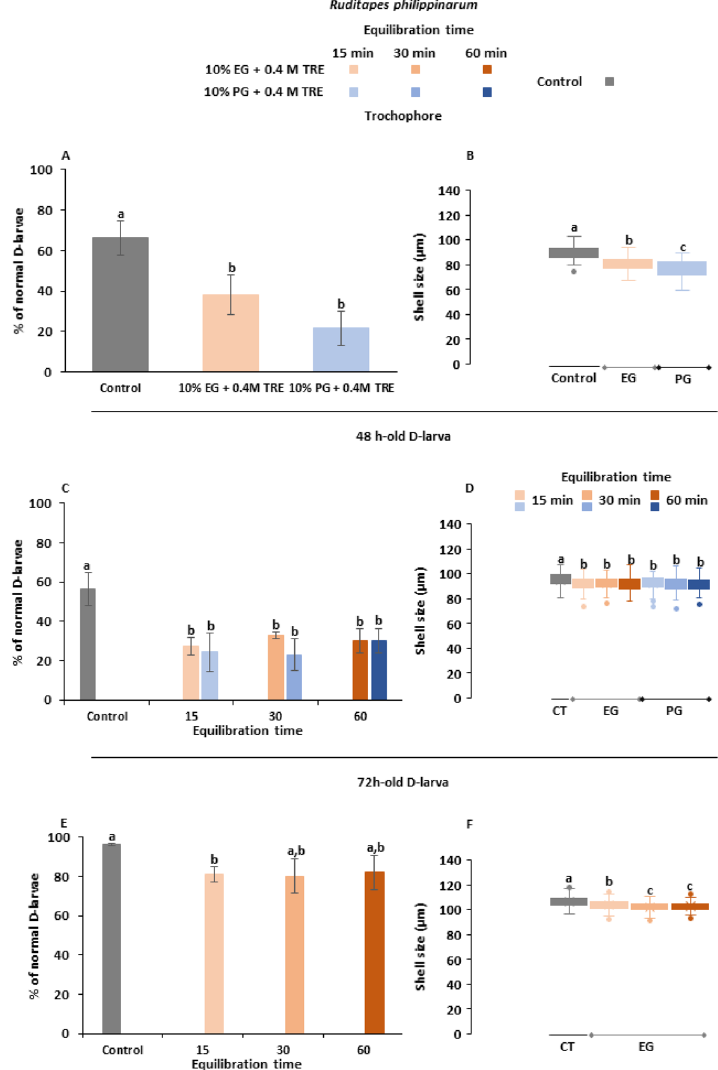
Figure 6. Post-thaw fitness parameters on larvae of Ruditapes philippinarum cryopreserved at trochophore, 48 and 72 h-old D-larval stages: (A) survival of cryopreserved trochophores; (B) shell size of developed D-larvae from cryopreserved trochophores; (C) survival of cryopreserved 48 h-old D-larvae; (D) shell size of developed D-larvae from cryopreserved 48 h-old D-larvae; (E) survival of cryopreserved 72 h-old D-larvae; (D) shell size of developed D-larvae from cryopreserved 72 h-old D-larvae. Larvae were cryopreserved using two CPA solutions: 10% ethylene–glycol (EG) + 0.4 M trehalose (TRE) and 10% prophylene-glycol (PG) + 0.4 M TRE (final concentrations), both prepared in filtered sea water (FSW). Increasing equilibrium times were tested on D-larvae. Results are expressed as mean normal D-larval percentage ± standard deviation, SD (n = 100, 3 replicates per treatment) or as box plots for shell size assessments (µm) considering mean value (mean ± standard deviation, SD) (n = 35, 3 replicates per treatment). Different letters show statistical differences with p ˂